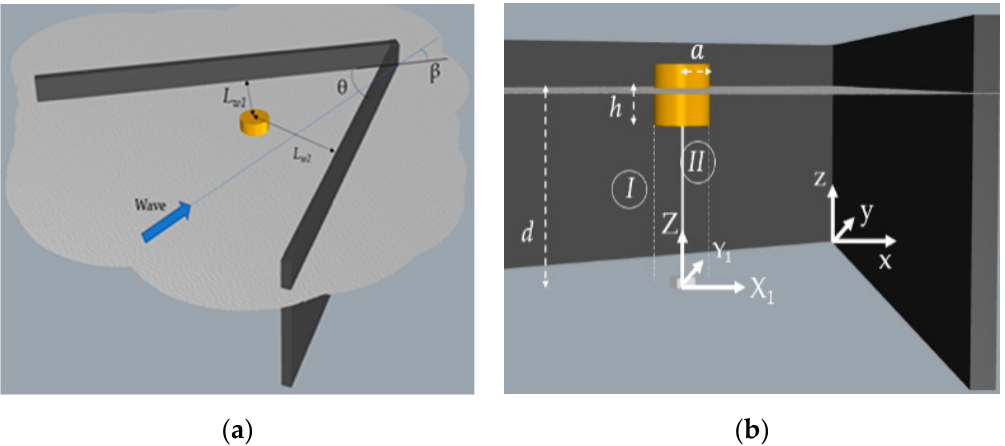
Figure 1. 3-D representation of a heaving WEC (wave energy converter) in front of a V-shaped breakwater of a random angle θ : ( a ) plane view; ( b ) side view.